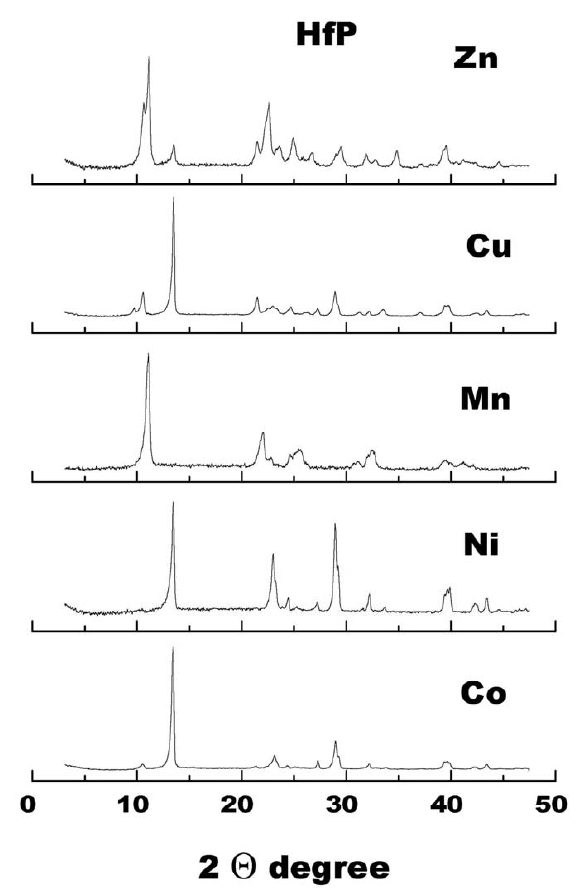
Fig. 3 A fragment of XRPD patterns of transition metal containing α -hafnium phos-